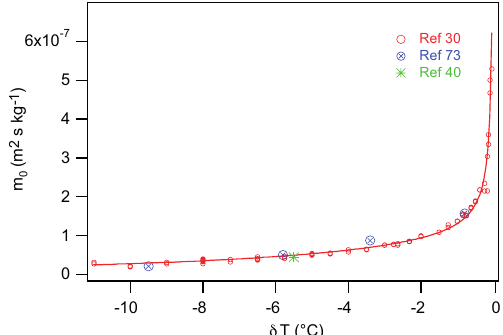
Figure 15. Mobility of elementary edge dislocations as a function of the temperature difference δ T = T − T NA (adapted from Ref. [30]). Errors on the mobility measurements are of the order of ±